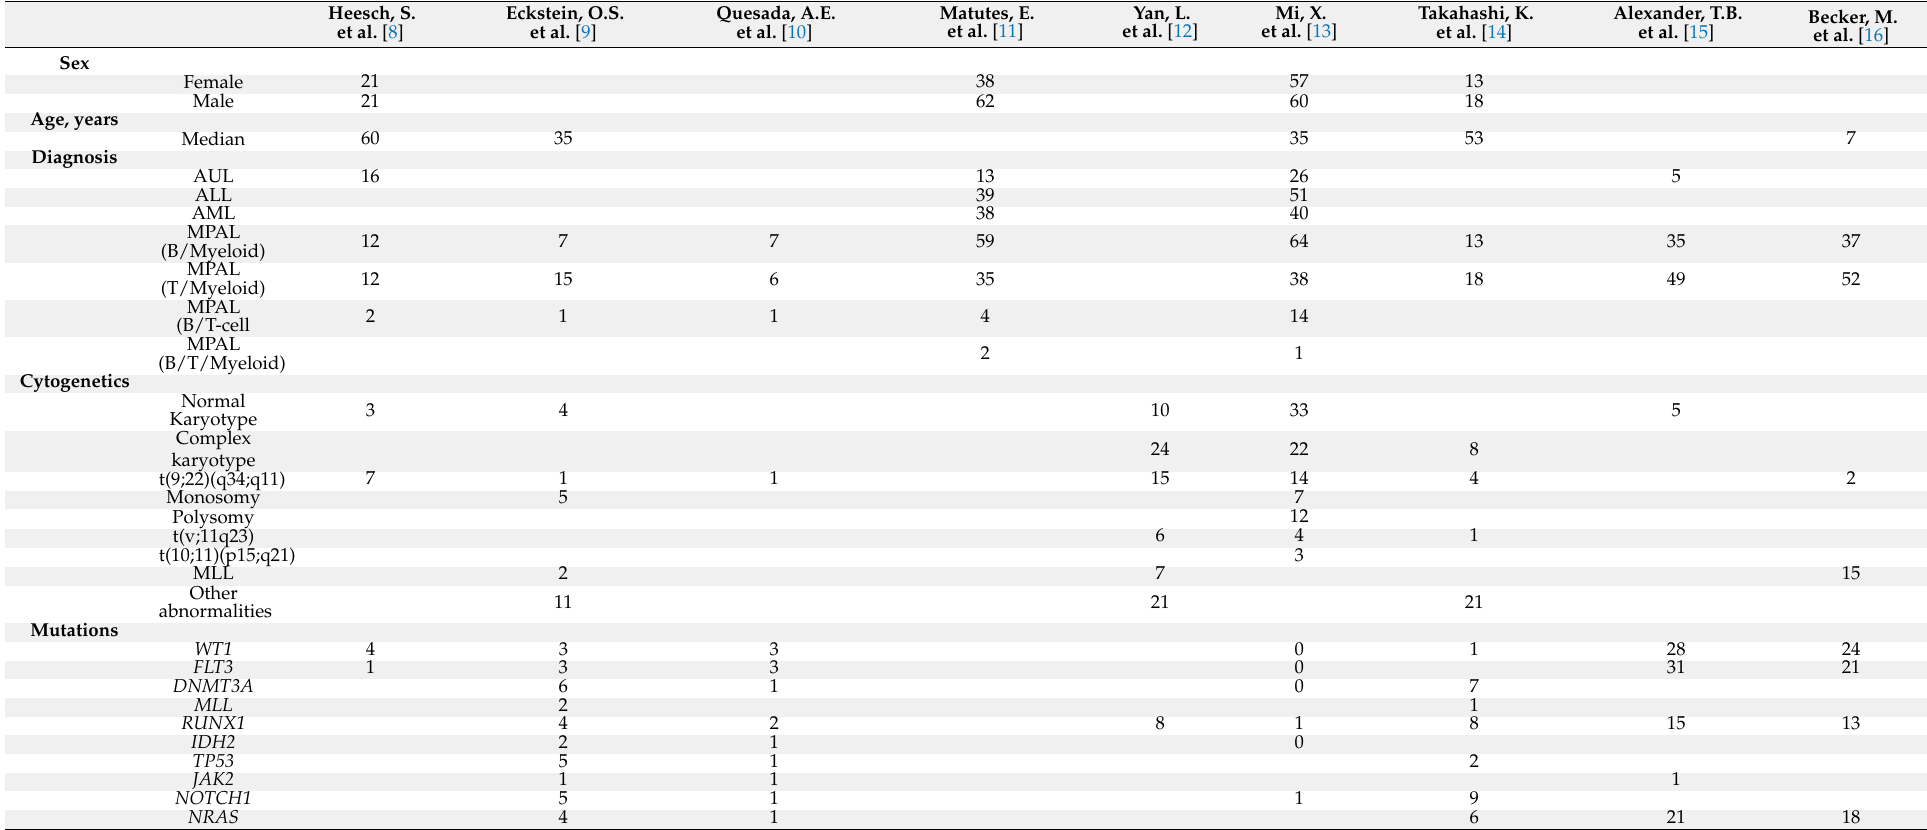
Table 2. Summary of prior genomic studies of